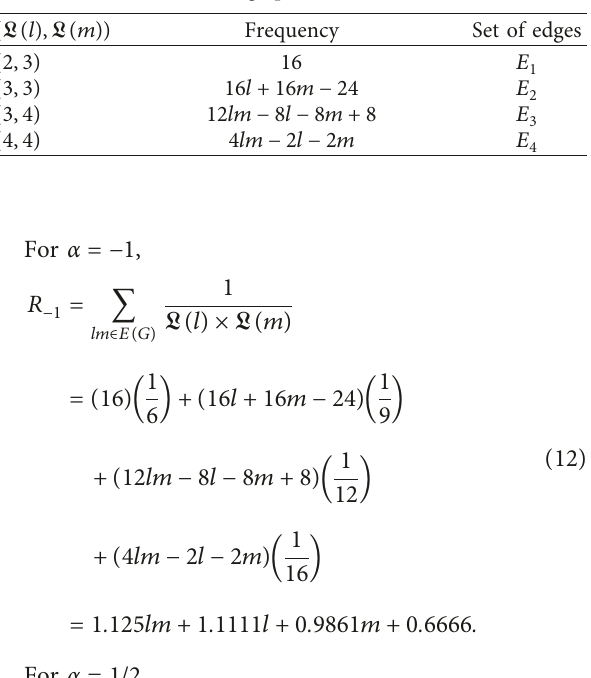
Table 2: Edge partition of